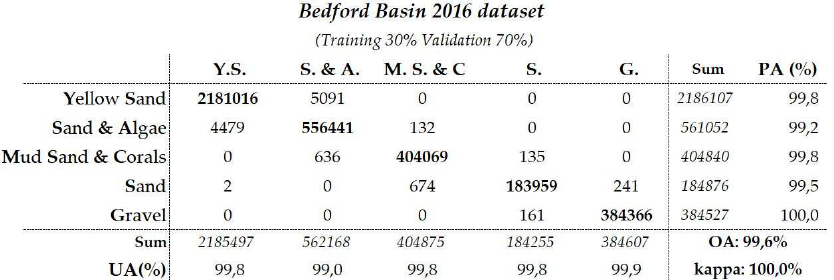
Table 1: The calculated Confusion Matrix of Bedford Basin 2016 as resulted from a RF